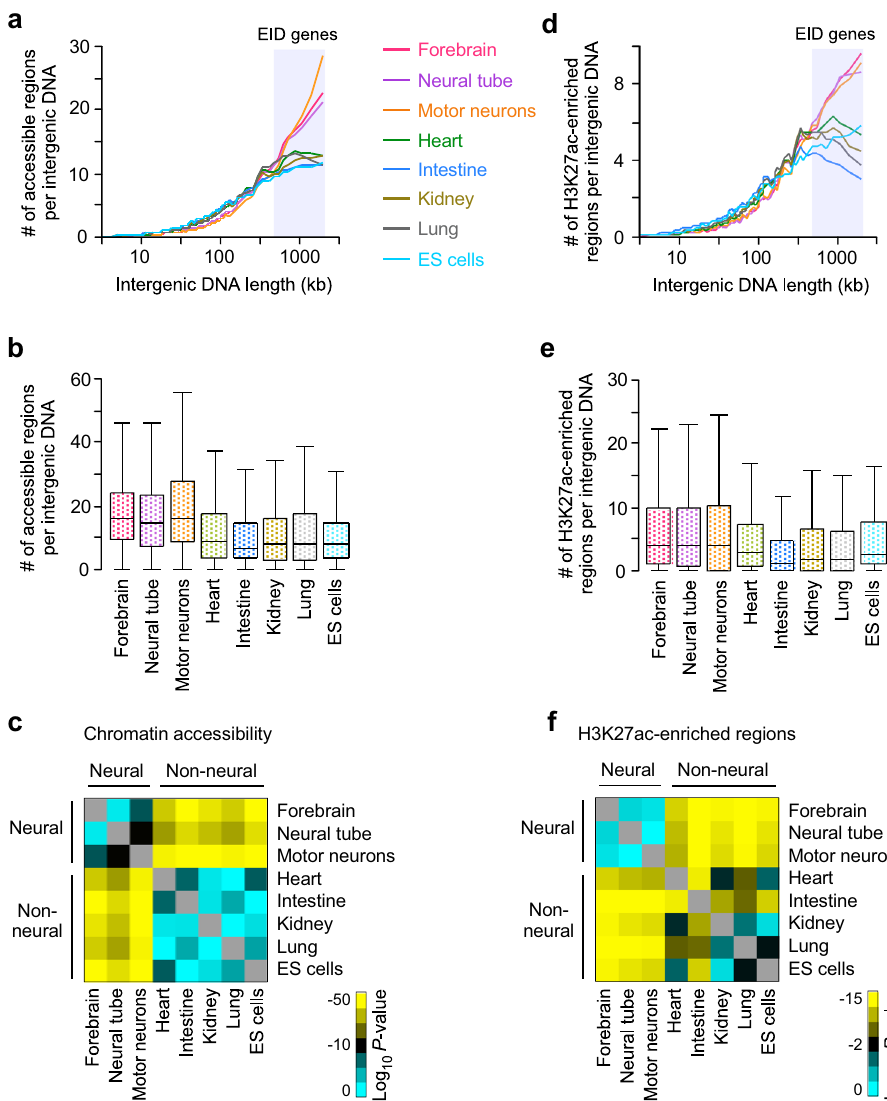
Fig. 4 Genes with long intergenic DNA have signi fi cantly more accessible and active enhancers in neural tissues than other tissues. a , d Average number of ATAC-seq peaks ( a ) and ChIP-seq H3K27ac peaks ( d ) per intergenic DNA region for genes, depending on the intergenic DNA lengths, in mouse tissues and cells shown in Fig. 3b. The lines indicate the average number of peaks for genes, binned according to the intergenic DNA lengths for each tissue and cell type (200 genes per bin, 18,383 mRNA genes, Supplementary Data 8). b , e Box plots of the number of ATAC-seq peaks ( b ) and ChIP-seq H3K27ac-enriched peaks ( e ) per intergenic DNA region of EID genes in each tissue and cell type (1621 genes), shown in the shaded areas in ( a , d ). The box plots show the median (line in a box), fi rst-to-third quartiles (box), and 1.5 × the interquartile range (whiskers). c , f Heatmap of the P -values (two-sided, two-sample t -test) for the difference in the number of ATAC-seq peaks ( c ) and H3K27ac-enriched peaks ( f ) per intergenic DNA regions of EID genes (1621 genes) between all pairwise combinations of tissues and cells, shown in ( b , e ). P -values were not adjusted for multiple comparisons. Yellow represents signi fi cant P -values, and black and cyan represent less or non-signi fi cant P -values (Supplementary Data